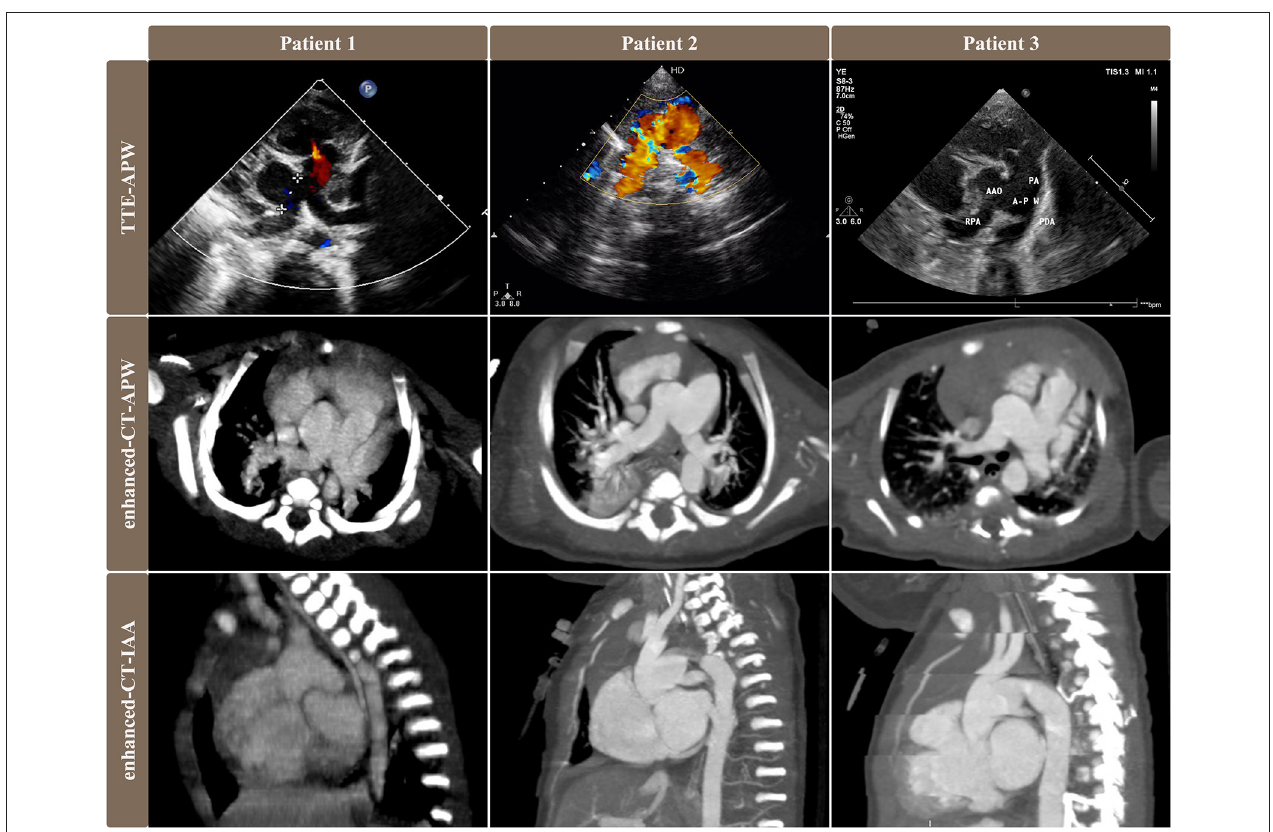
FIGURE 1 | Pre-operative images of transthoracic echocardiography and contrast-enhanced CT scan showed different types of APW, AORPA, and IAA in 3 patients. Images of the first and second rows showed the relationship among RPA, AAO, APW, and PA. Patient No. 1 was APW type IIa, patient No. 2 was APW type III, and patient No. 3 was APW type IIb. Images of the third rows were sagittal views of CT exhibiting IAA that descending aorta originated from PDA.TTE, transthoracic echocardiography; APW, aortopulmonary window; AORPA, the aortic origin of the right pulmonary artery; IAA, interrupted aortic arch; RPA, right pulmonary artery; AAO, ascending aorta; PA, pulmonary artery; PDA, patent ductus